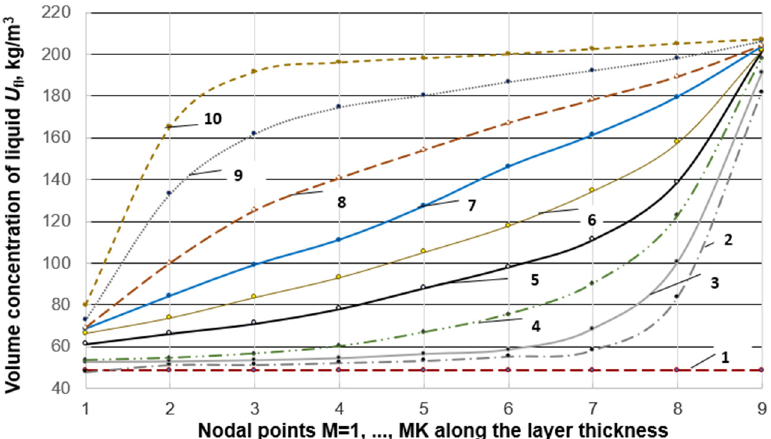
Figure 4. Dynamics of liquid volume concentration U fl change along the height H of the oil dispersed layer at nodal points m ( МК = 9) in the cross-section along the radius r = R /2 ( i = 5) humidified in the first vat: 1 − t = 0 min, 2 − t = 1 min, 3 − t = 2 min, 4 − t = 3 min, 5 − t = 4 min, 6 − t = 5 min, 7 − t = 6 min, 8 − t = 7 min, 9 − t = 8 min, 10 − t = 8.57 min.